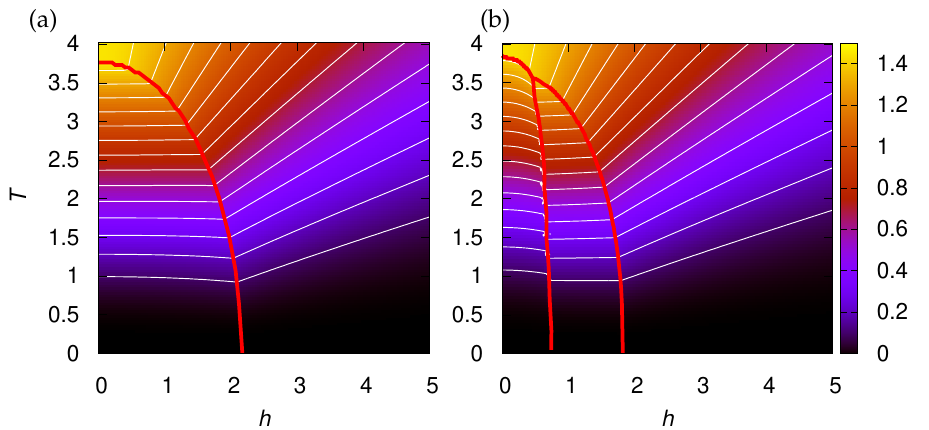
Figure A4. Single-site mean-field results for the entropy per spin at J = 1, J ⊥ = 0.5, and D = 0 ( a ) and at D = 0.1 ( b ). Red lines are the phase boundaries from Figure